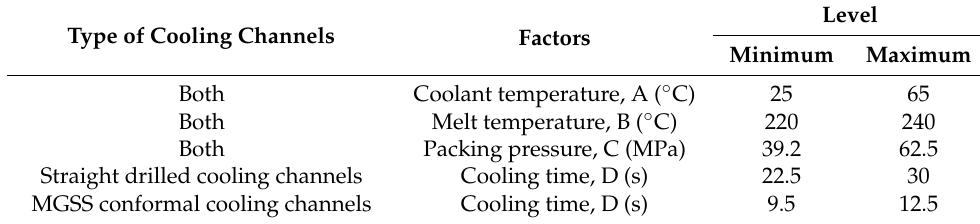
Table 2. Variable parameters and